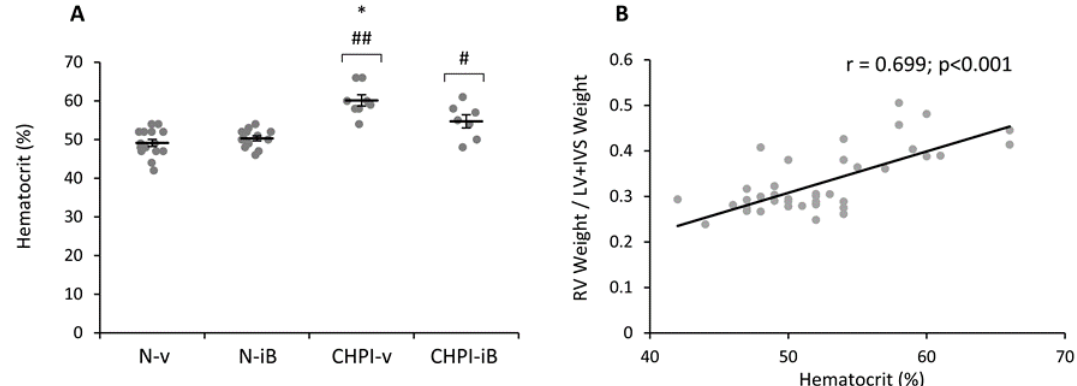
Figure 4. Hematocrit levels of animals in each groups ( A ); Relationship between right ventricle hypertrophy and the hematocrit level of the animal treated with vehicle or with I-BET151 ( B ). IVS: Interventricular Septum; RVDP: Right Ventricle Diastolic Pressure; N-v: Normoxia + vehicle; N-iB: Normoxia + I-BET151; CHPI-v: Chronic Hypoxia + Inflammation + vehicle; CHPI-iB: Chronic Hypoxia + Inflammation + I-BET151. Horizontal bars represent the mean ± SEM; n = 7–15. #: diff. of N-v and N-iB (#: p < 0.05; ##: p < 0.001); *: diff. of CHPI-v ( p < 0.05).